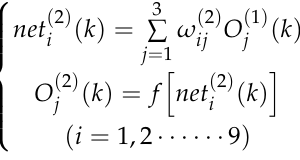
Figure 8. Fuzzy-BPNN-PID structure diagram.